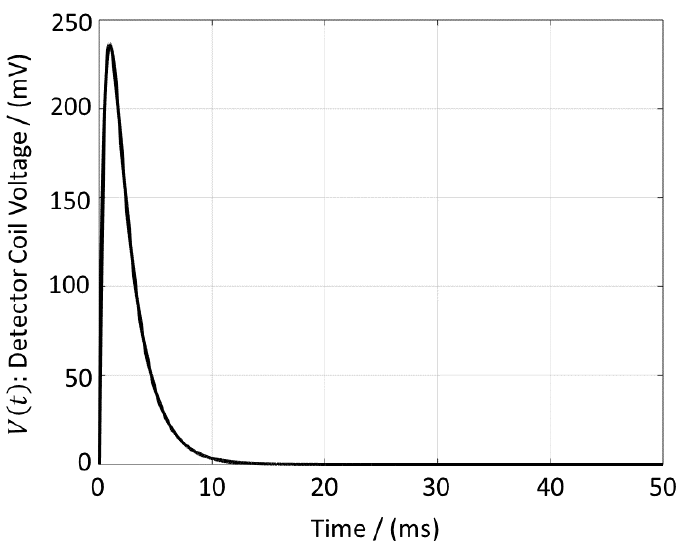
Figure 1. Example for typical shape of a detector coil-based Pulsed Eddy Current (PEC)